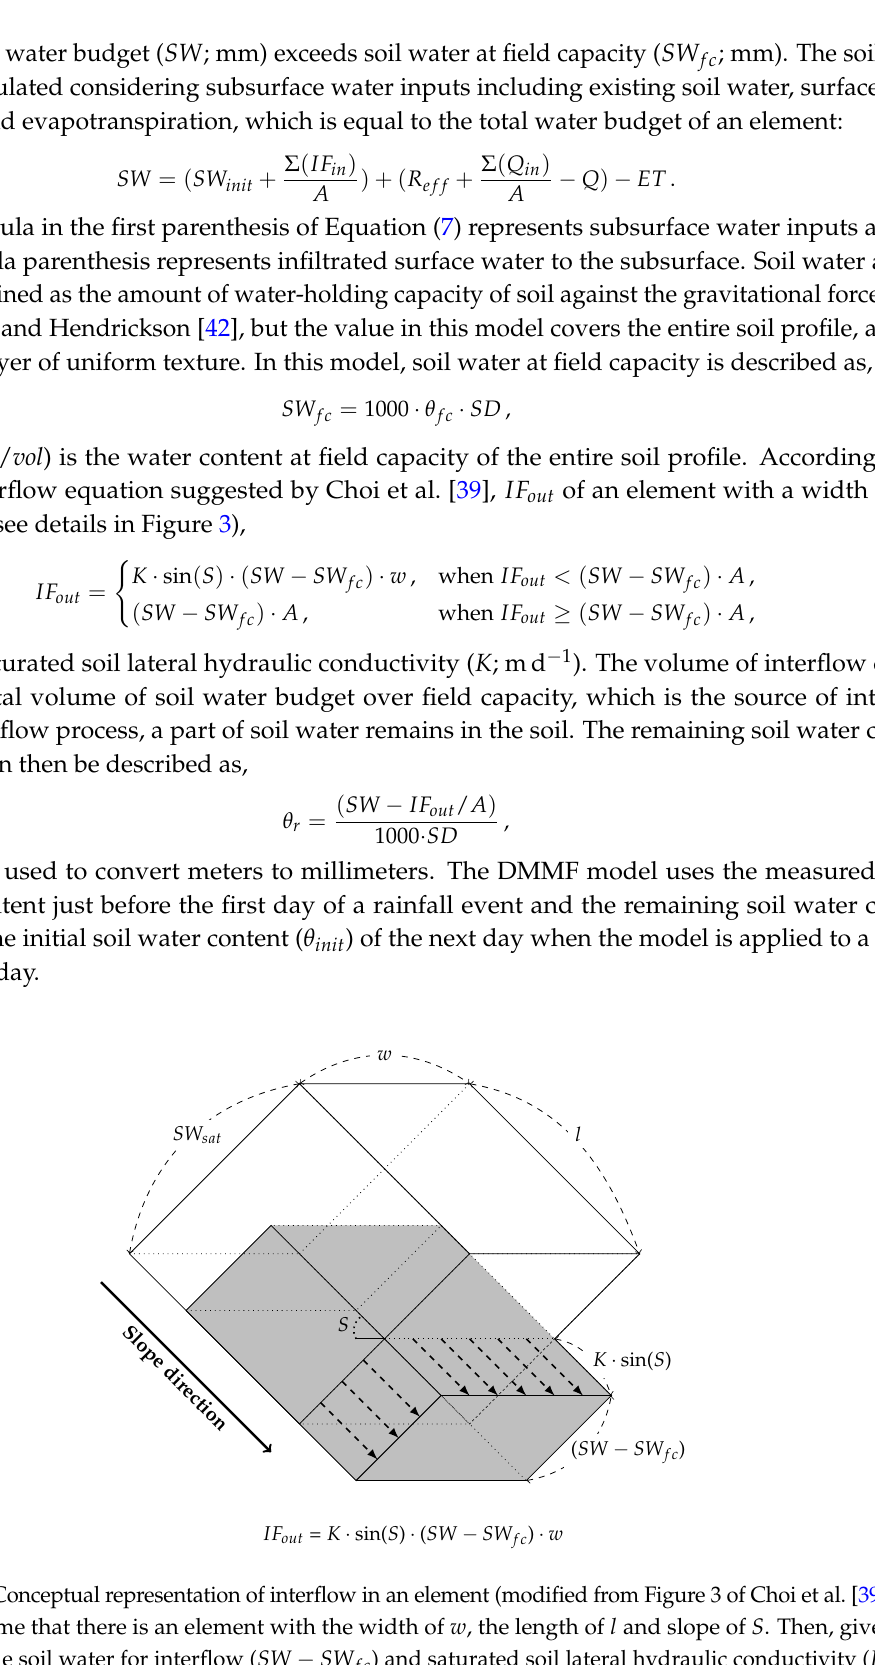
( SW sin ( S ) SW fc ) w , · · − · SW fc ) A − ·